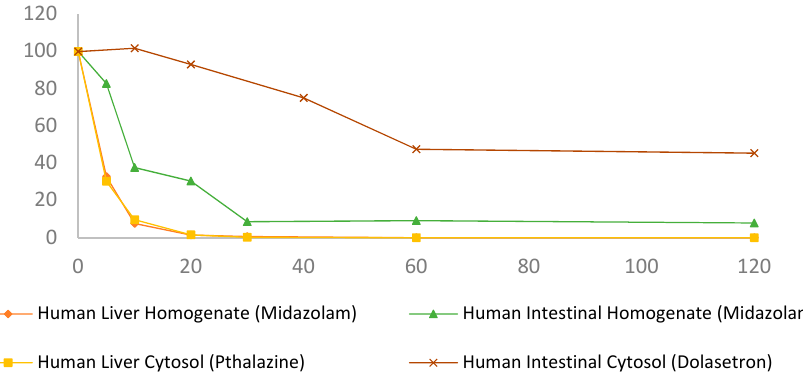
Figure A2. Concentration (expressed as percent of initial value) of control substances as function of incubation time with human liver and intestinal homogenates and cytosol. Progesterone Clearance in Liver Cytosol (-NADPH).